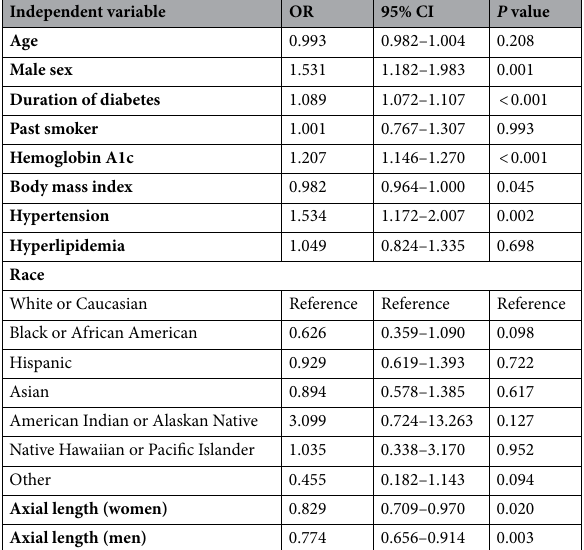
Table 2. Results of multivariable logistic regression with diabetic retinopathy as the dependent variable. OR odds ratio, CI confidence